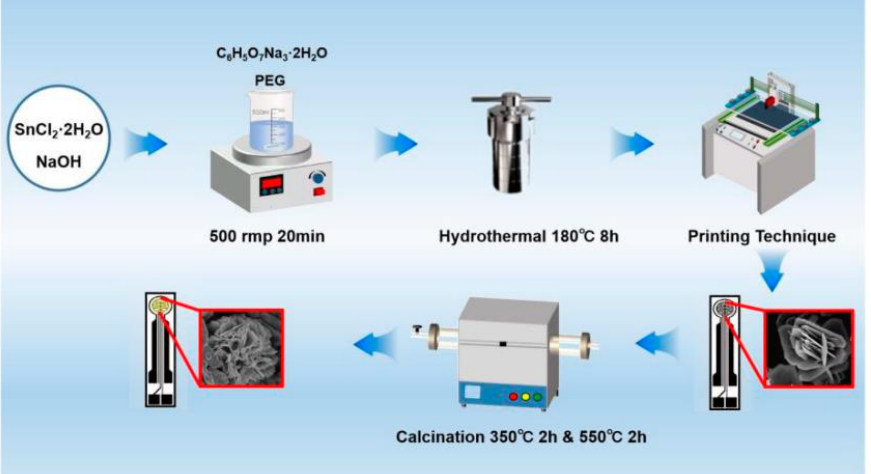
Figure 1. Schematic illustrating for the formation process of Sn/SnO 2 sample.